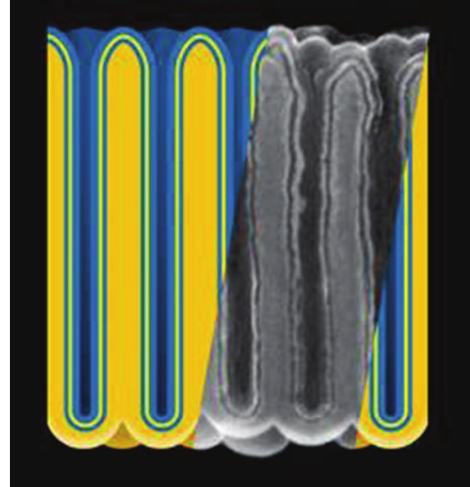
Figure 21: Electrostatic nanocapacitor. Developed by Maryland NanoCenter [58].